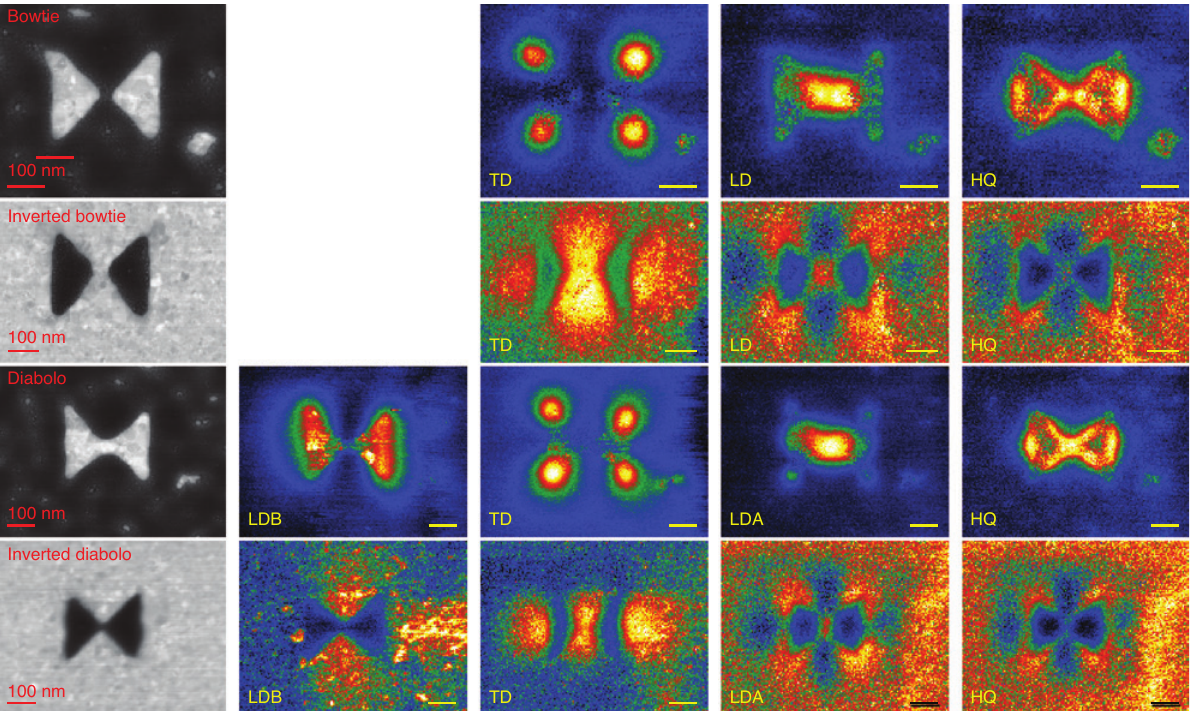
Figure 5: HAADF images of the antennas of all four types and spatial maps of the loss function at the energy corresponding to specific LSP modes: longitudinal dipolar bonding (LDB), antibonding (LDA), and, in the case of bowtie antennas, unresolved (LD), transverse dipolar (TD), and hexapolar–quadrupolar (HQ). The energy of the modes increases from left to right. The wing length of all antennas is comparable: 140 nm (bowtie), 150 nm (diabolo), 150 nm (inverted bowtie), 140 nm (inverted diabolo). The length of the scale bars is 100